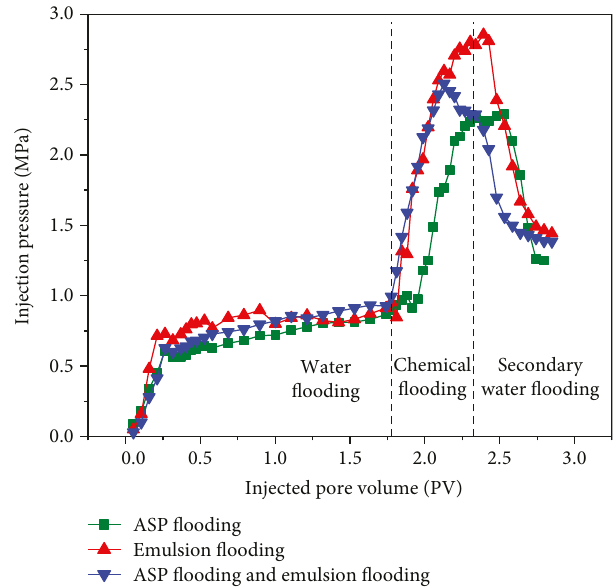
Figure 14: Injection pressure variation curve of di ff erent chemical fl ooding.